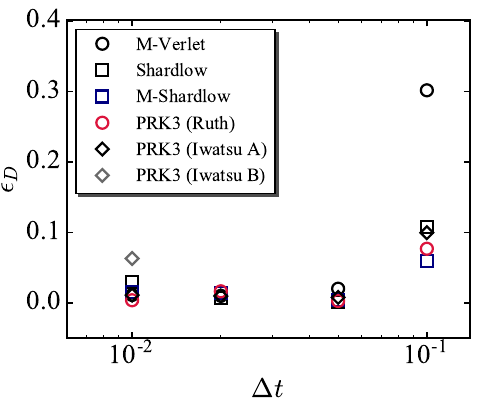
Figure 6. Error in diffusion coefficient calculated using Equation (26) as a function of ∆ t on different time integration